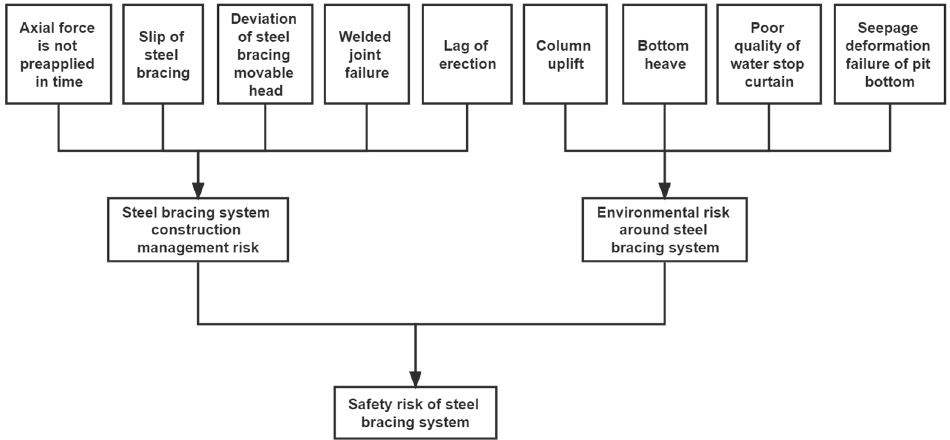
Figure 4. Relationship between risk factors and